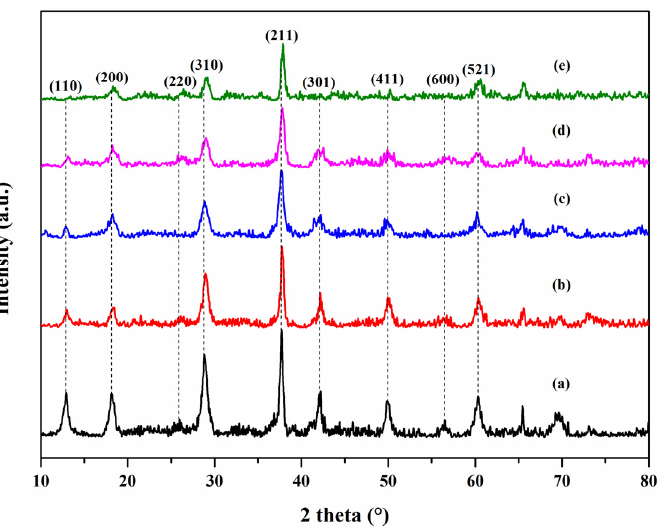
Figure 1. XRD patterns of ( a ) OMS-2, ( b ) 1Ni/OMS-2, ( c ) 3Ni/OMS-2, ( d ) 5Ni/OMS-2, and ( e )